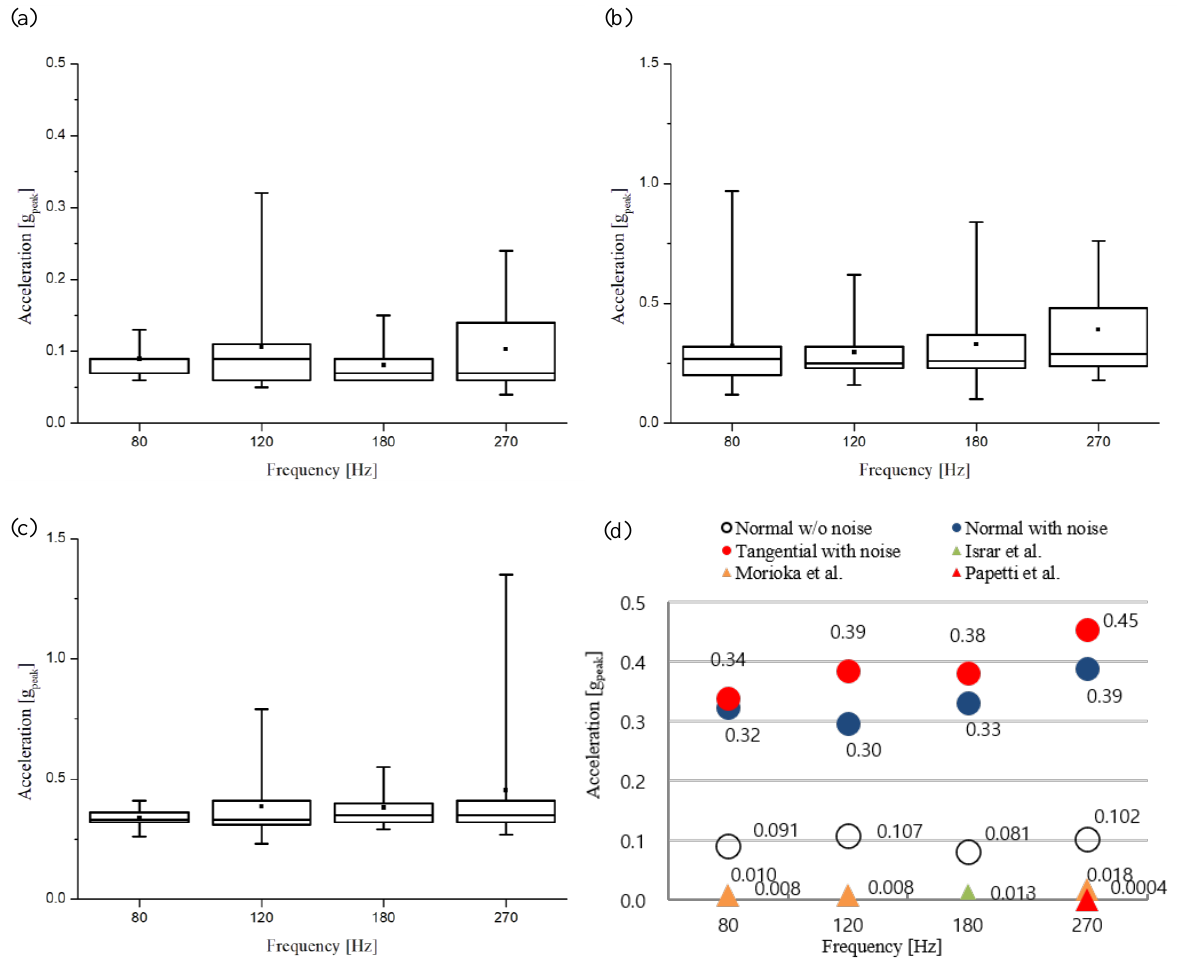
Figure 5. Experimental results of the detection threshold expressed as acceleration. ( a ) For the normal direction without driving vibration. ( b ) For the normal direction with driving vibration. ( c ) For the tangential direction with driving vibration. ( d ) Comparison of experimental results and previously published data.